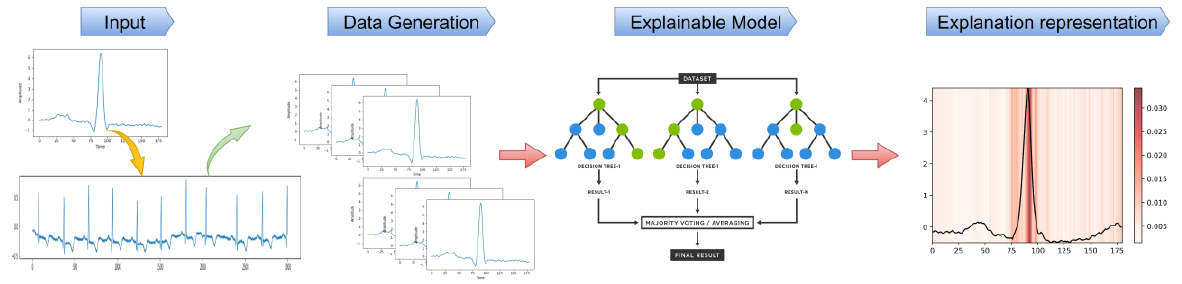
Figure 2. B-LIME procedure to generate explanations.